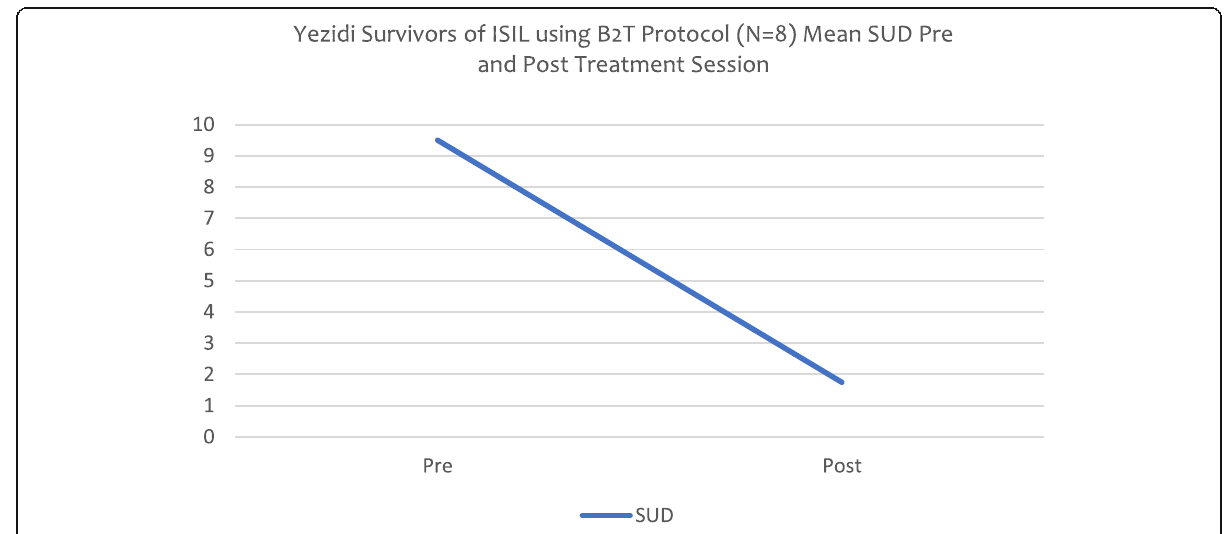
Fig. 3 Mean pre- and post-measures of SUD with Yezidi survivors using B2T EMDR Therapy